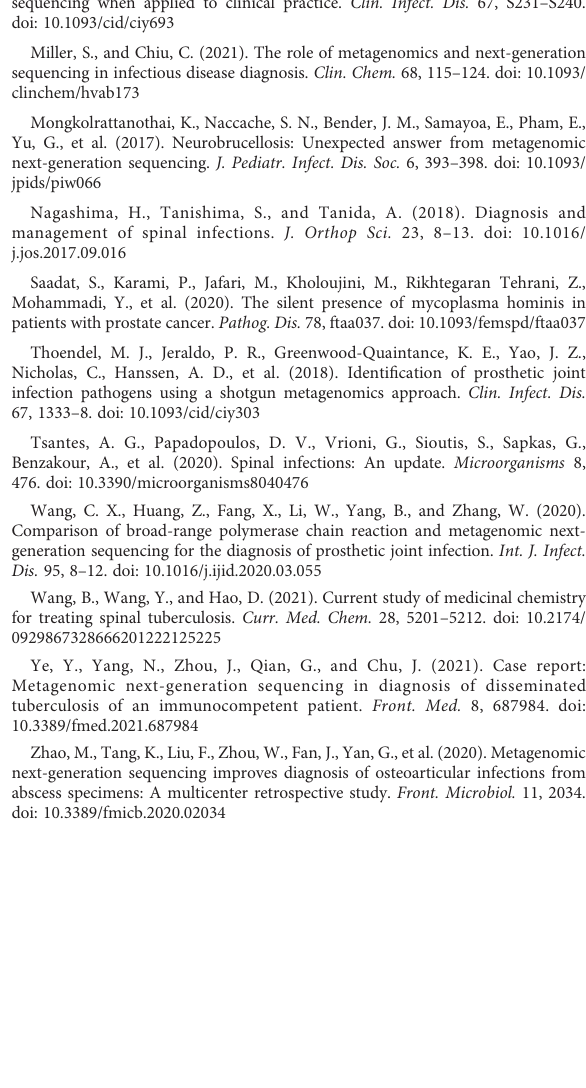
SUPPLEMENTARY FIGURE 1 Images show the histopathological examination of spinal infection. (A) The blue circle indicates the tubercles, and the yellow arrows indicate the Langhans multinucleated giant cells; (B) The red circles indicate caseous necrosis; (C) The blue circles indicate the granulomatous tubercles; (D) The red circle indicates caseous necrosis, and the yellow arrows indicate the Langhans multinucleated giant cells.